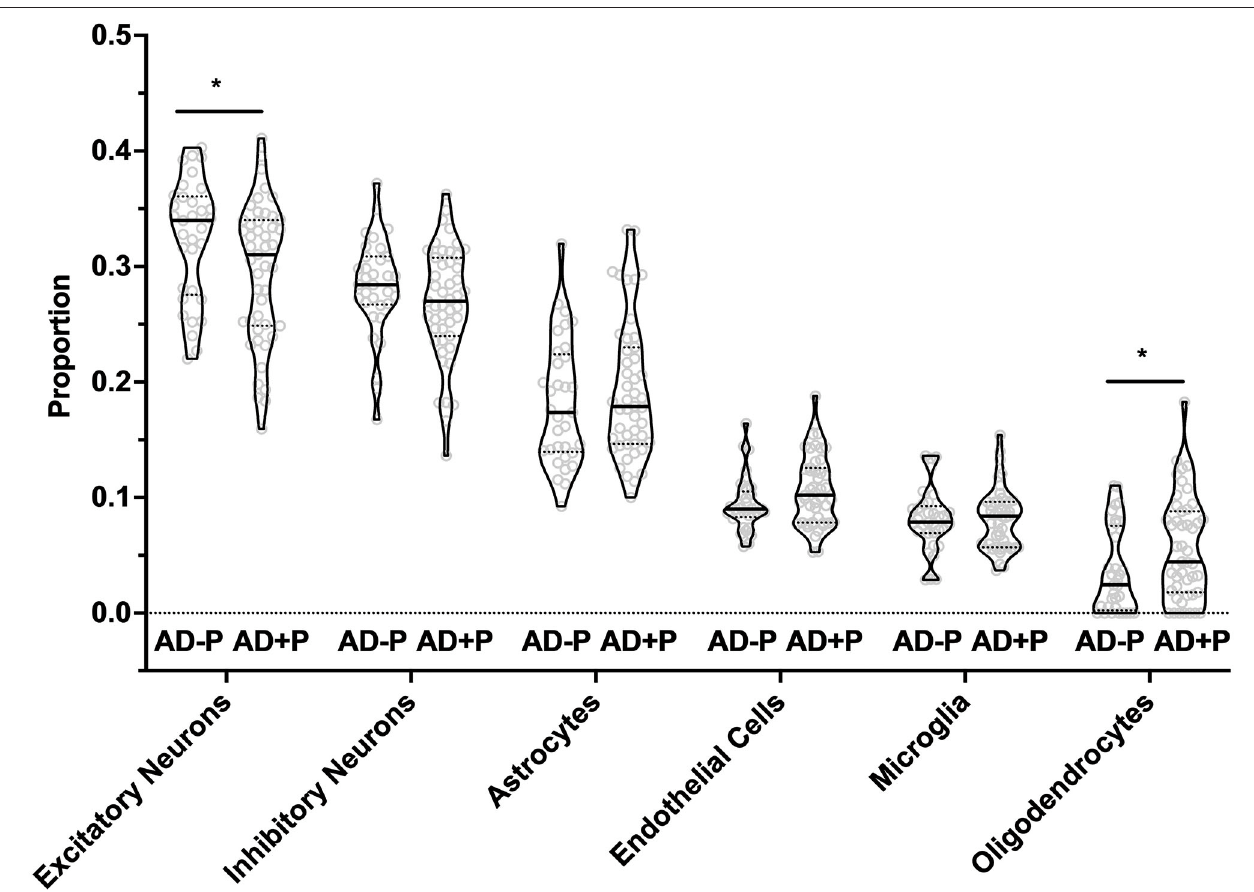
FIGURE 1 | Excitatory Neurons, Oligodendrocytes, and Endothelial Cell proportions are altered in AD + P. Cell type proportion differences between AD + P and AD–P were determined using MIND signature gene matrix ( 32). Excitatory neuron proportion was significantly reduced in AD + P subjects compared to AD–P ( T = 2.27 df = 75, p = 0.026). Conversely, oligodendrocyte ( T = − 2.17, df = 76, p = 0.033) and endothelial cell ( T = − 1.93, df = 78, p = 0.057) proportions were increased in AD + P compared to AD–P. Proportions of astrocytes, microglia, and inhibitory neurons did not differ between groups (astrocyte T = − 0.90, df = 73, p = 0.372 microglia T = − 0.03, df = 67, p = 0.978; inhibitory neuron T = 1.40, df = 74, p = 0.166). *Indicates p < 0.05.